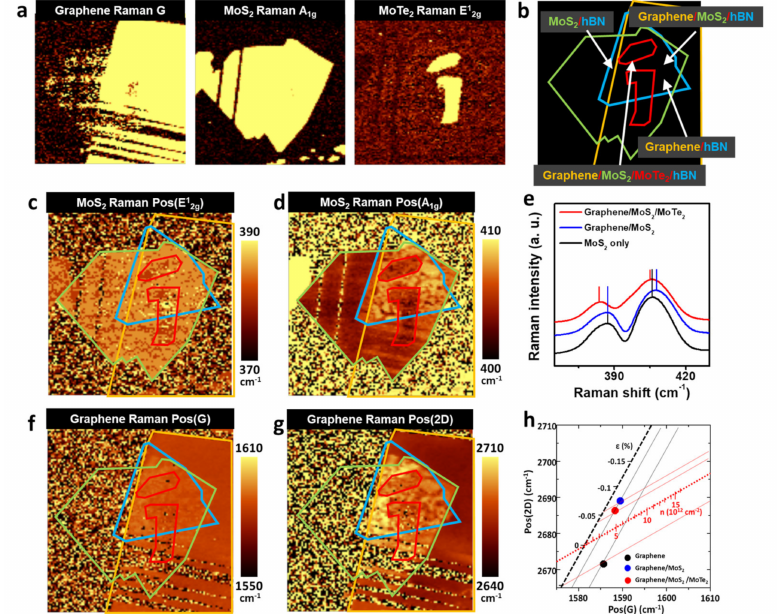
Figure 2. ( a ), Raman intensity maps of G peak of graphene ( left ), A 1g peak of MoS 2 ( middle ), and E 1 2g peak of MoTe 2 ( right ). ( b ), Locations of graphene (orange), MoS 2 (green), MoTe 2 (red), and hBN (blue) as determined using Raman spectroscopy and optical microscopy. ( c ), Pos(E 1 2g ) and ( d ), Pos(A 1g ) maps of MoS 2 layer. ( e ), Raman spectra of MoS 2 in MoS2-only region (black), graphene/MoS 2 region (blue), and graphene/MoS 2 /MoTe 2 region (red). ( f ), Pos(G) and ( g ), Pos(2D) maps of graphene. ( h ), Average Pos(G) and Pos(2D) values in Raman spectra of graphene in graphene-only region (black), graphene/MoS 2 region (blue), and graphene/MoS 2 /MoTe 2 region